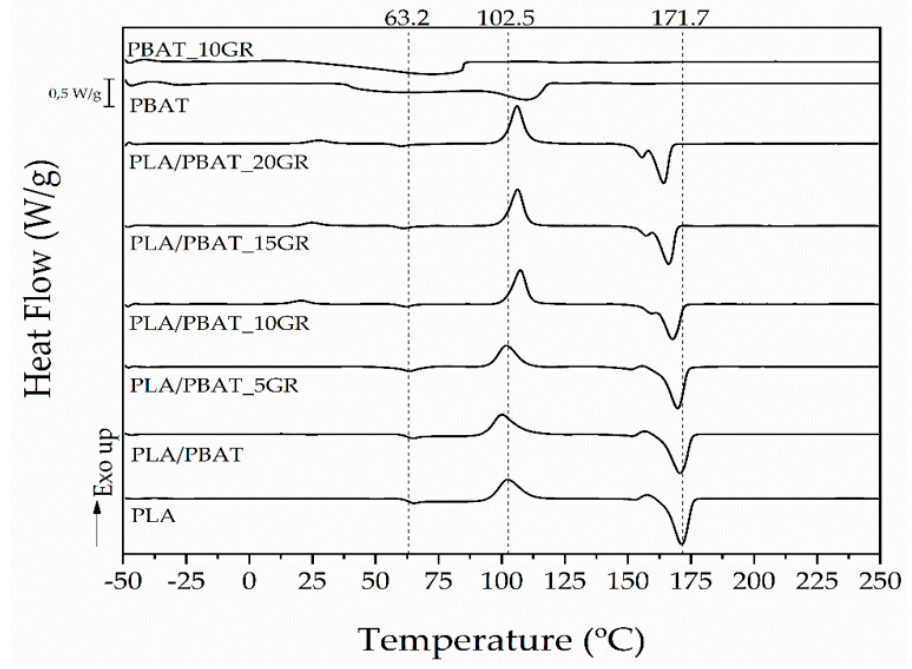
Figure 4. DSC curves of PLA, PBAT, PBAT_10GR, and the studied PLA/PBAT formulations with different content of GR. Table 4. Thermal properties of studied formulations and neat matrixes materials.